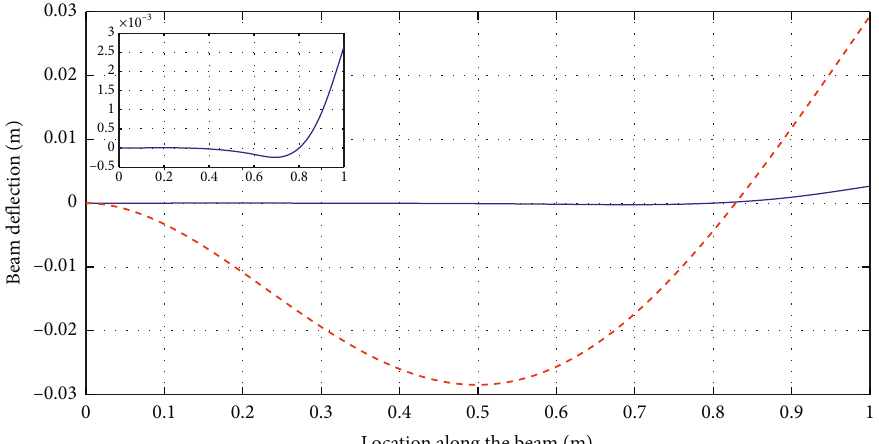
Location along the beam � 0 . 3, x � 0 . 8, x � 0 . 6, and x � 0 . 9. The inset shows the detailed plot of the controlled n 1 n 2 a 1 a 2